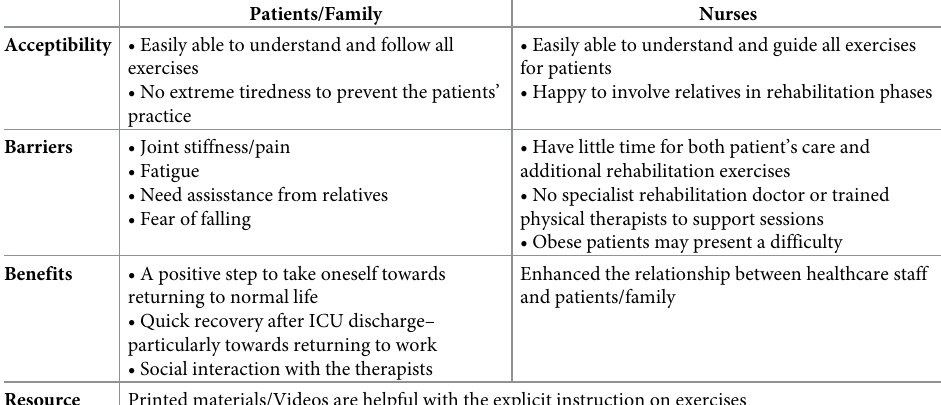
Table 2. Results from patients/relatives and healthcare nurses about rehabilitation program during